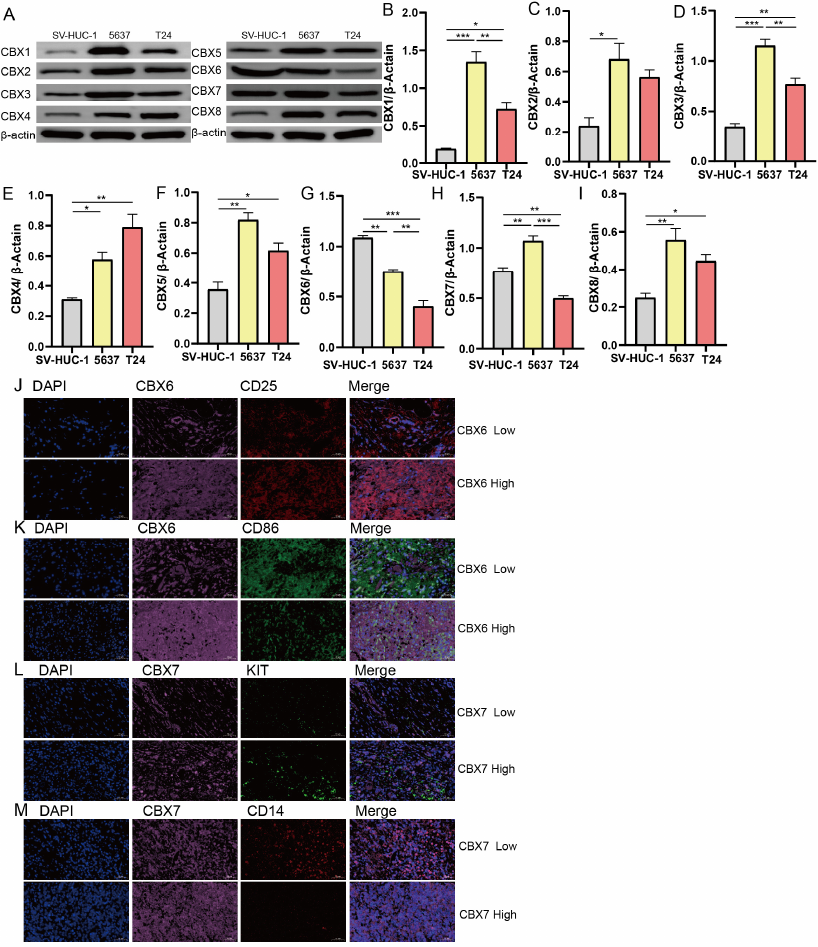
Figure 11. Validation of CBX family protein expression levels in BLCA cell and tissue samples. ( A ) The expression levels of CBX family proteins were detected by Western bloing in normal urothelial cell lines (SV-HUC-1) and BLCA cell lines (5637 and T24) (n = 3). ( B – I ) Quantitative results of ( A ). ( J , K ) Expression levels of CBX6, CD25, and CD86 in BLCA tumor tissue samples analyzed by im- munohistochemistry (IHC). ( L , M ) Expression level of CBX7, KIT, and CD14 analyzed by IHC in BLCA tumor tissue samples. * p < 0.05; ** p < 0.01; *** p < 0.001. 3.10. mIHC Results Confirm the Relationship between CBX6 and CBX7 Expression and Immune Cells Given that the hypothesized relationship between CBX6, CBX7, and immune cells in the TME may be essential to its function, mIHC was performed on BLCA pathology spec- imens to further confirm their potential importance. When tumor tissue exhibited low CBX6 expression, the infiltration of regulatory T cells (Tregs) (labelled by CD25) was markedly inhibited in the tumor center. In contrast, T cell regulatory (Treg) recruitment was particularly active in regions with high CBX6 levels (Figure 11D). Moreover, con- sistent with the preceding findings, the numbers of M1 macrophages (marked by CD86) and CBX6 had strikingly contrasting trends. Therefore, the polarization process of M1 TAMs may be profoundly reduced by active CBX6 expression (Figure 11E). These prelim- inary findings confirmed our bioinformatics study conclusions that CBX6 was associated